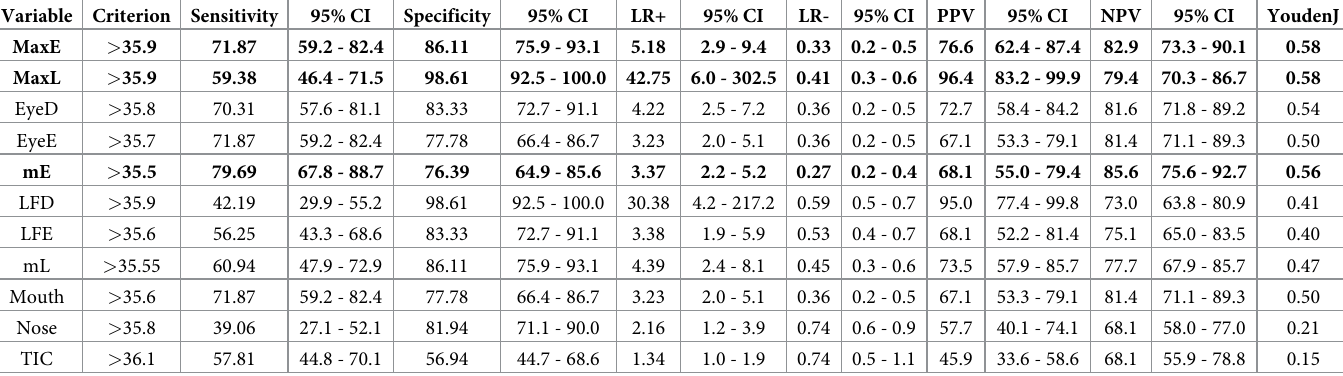
Table 3. Criterion validity for all infrared parameters evaluated in this study. The cutoff values represent the best trade-off between sensitivity and specificity in the 136 patients analyzed in the emergency room of HU-USP Hospital, S ã o Paulo, Brazil. Variable Criterion